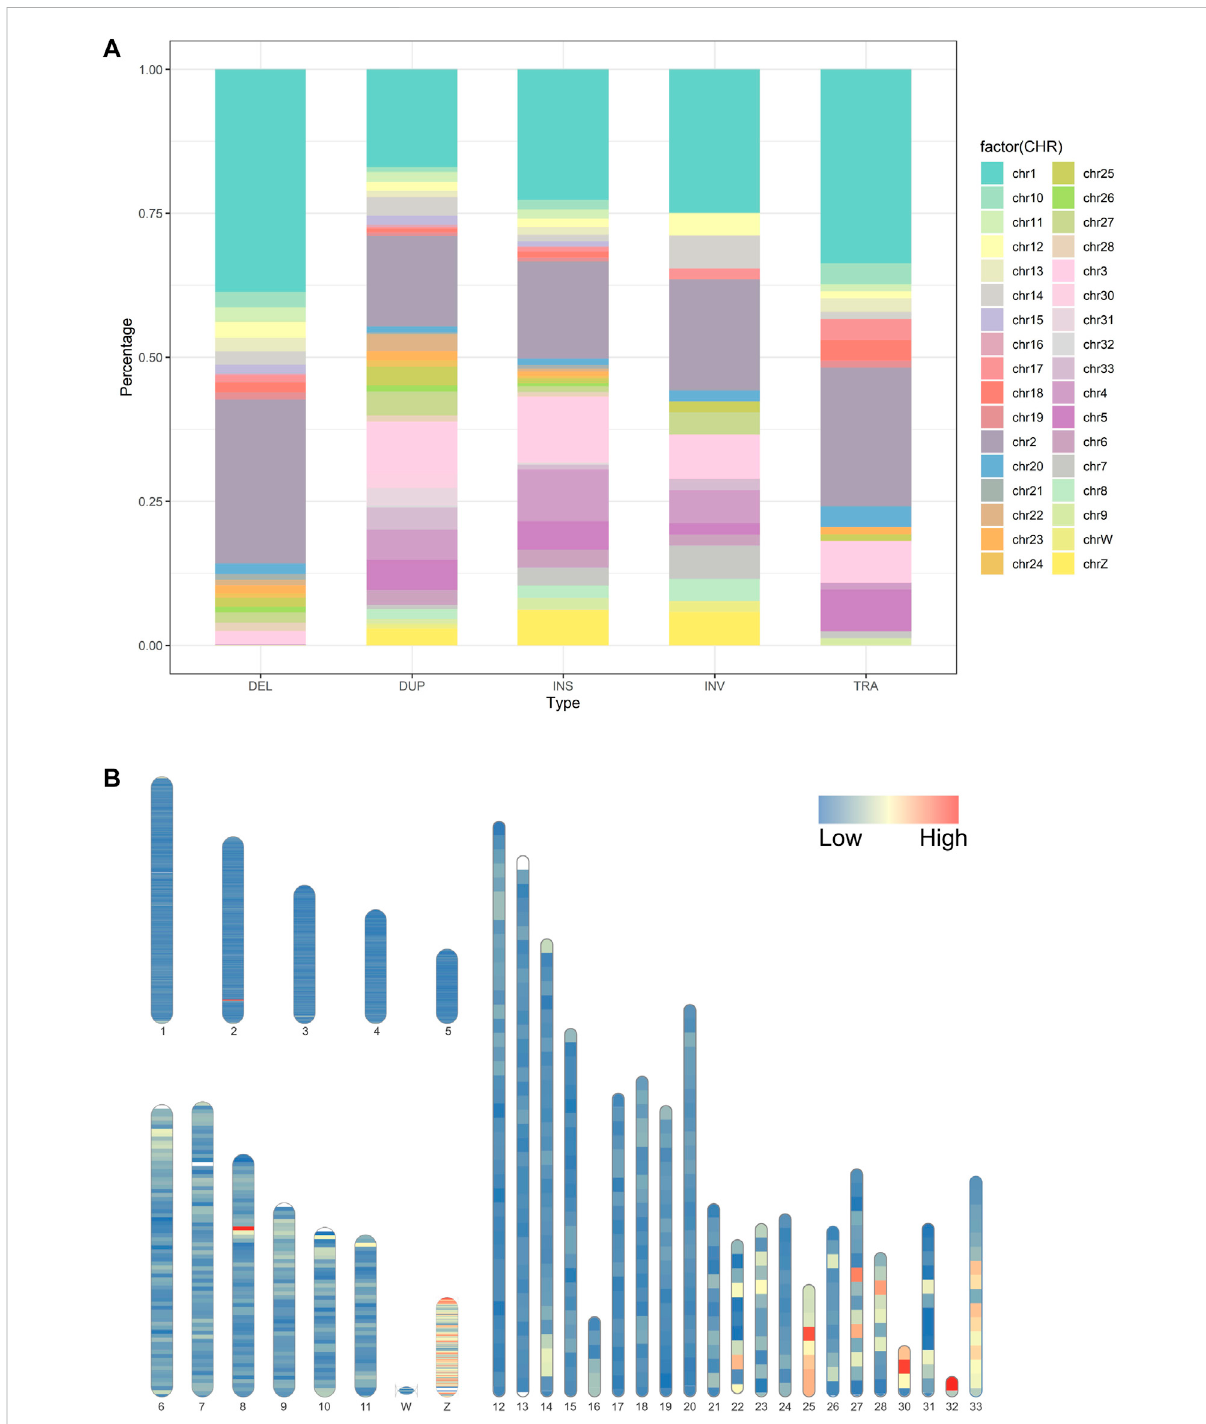
FIGURE 3 (A). Distribution of structural variations among the chicken chromosomes; (B) . Distribution of the SV density on chicken chromosome ideogram. This was drawn using Rideogram R package. Note: Macro-chromosome (1-5); Intermediate-chromosome (6-11); Micro-chromosome (12-28, 33); Sexual-chromosome (W,